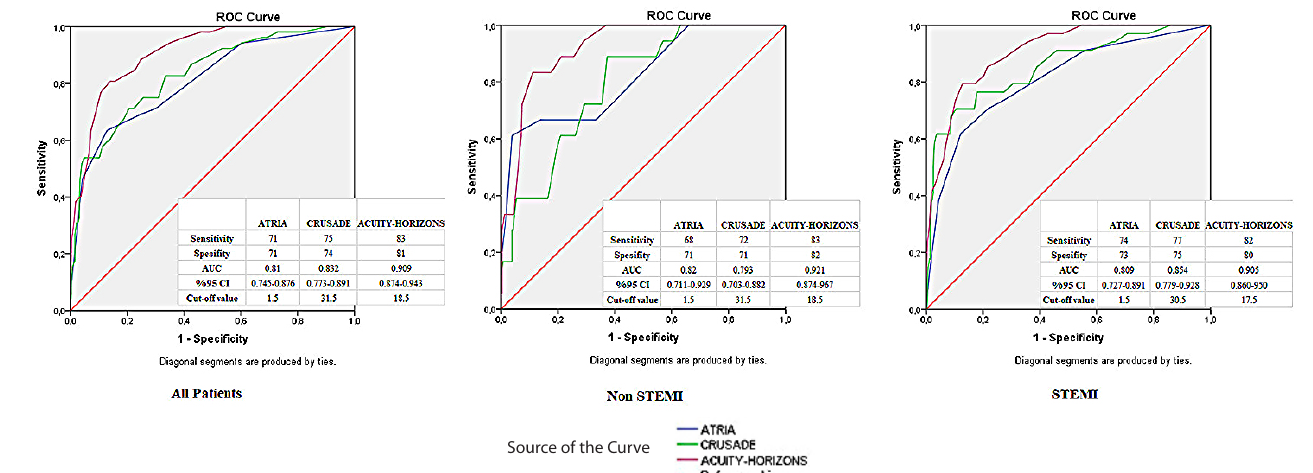
Fig. 1 - Receiver-operating characteristic (ROC) curves of major bleeding according to the ATRIA, CRUSADE, and ACUITY HORIZONS scores in the entire cohort and STEMI and non-STEMI subgroups. ACUITY-HORIZONS=Acute Catheterization and Urgent Intervention Triage strategY- Harmonizing Outcomes with Revascularization and Stents in Acute Myocardial Infarction; ATRIA=Anticoagulation and Risk Factors in Atrial Fibrillation; AUC=area under the curve; CI=confidence interval; CRUSADE=The Can Rapid Risk Stratification of Unstable Angina Patients Suppress Adverse Outcomes With Early Implementation of the ACC/AHA